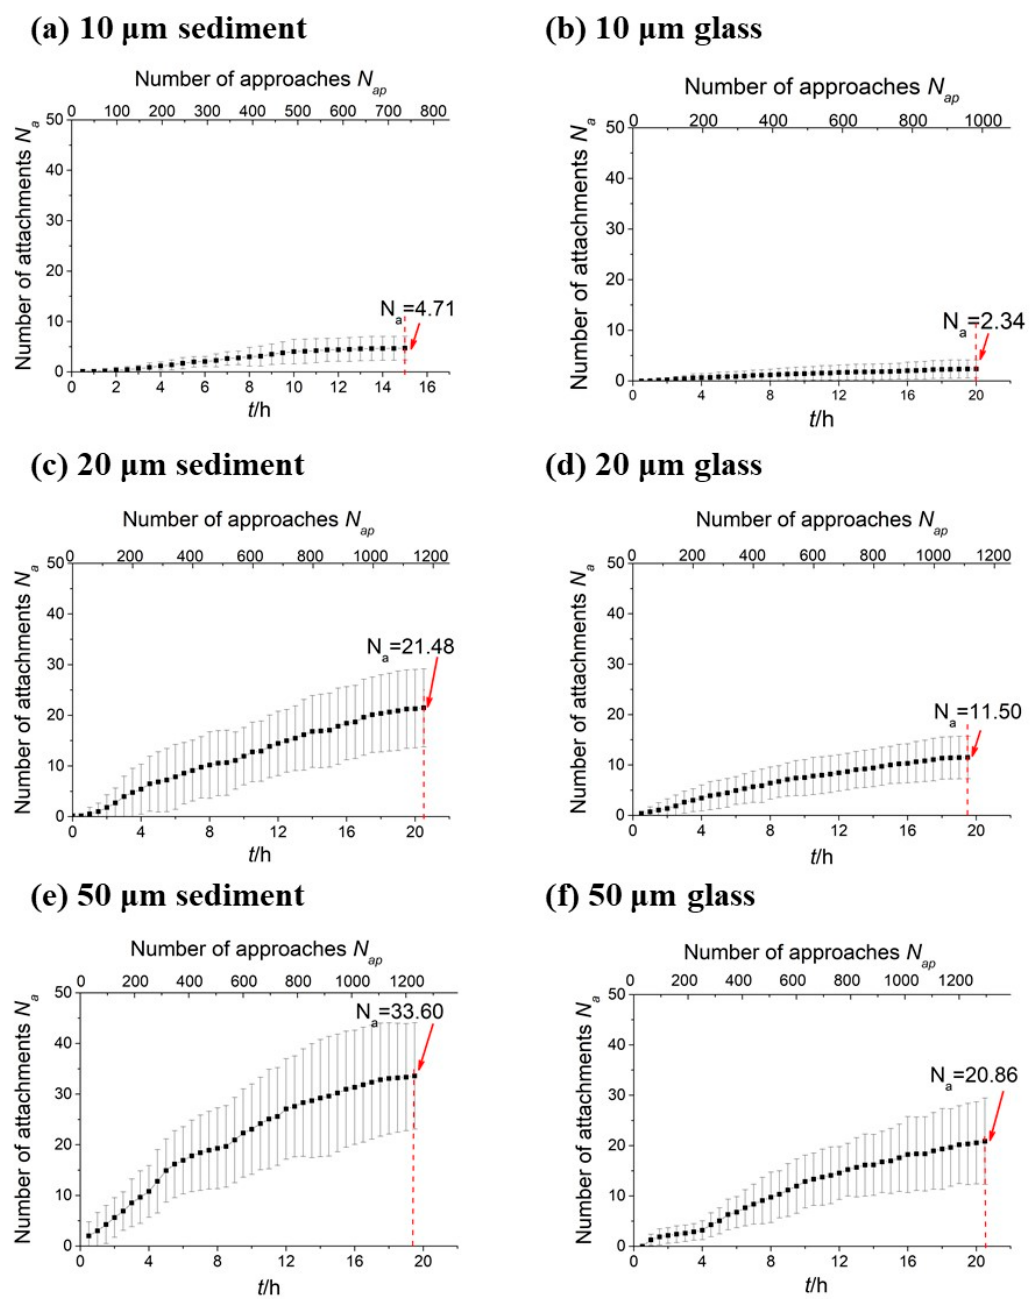
Figure 2. Time evolution of bacterial attachment to particles of di ff erent sizes. ( a , c , e ) are for 10 µ m, 20 µ m, and 50 µ m sediment particles, respectively; ( b , d , f ) are for 10 µ m, 20 µ m, and 50 µ m glass microspheres, respectively. The results were obtained by averaging 30 samples for each type of particle. Red arrows show the final measured numbers of attachments.